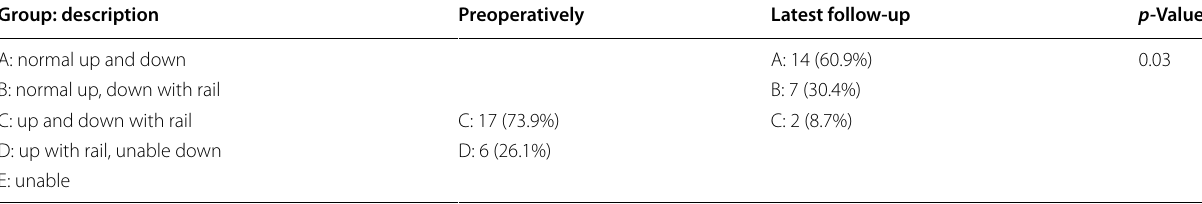
Pearson’s chi-square test ( p < 0.05)